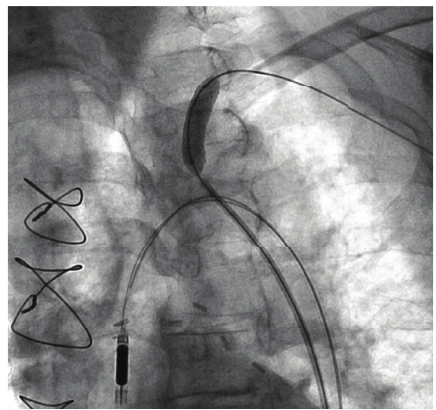
Figure 5: A stent deployment in the subclavian artery with the support of Impella.